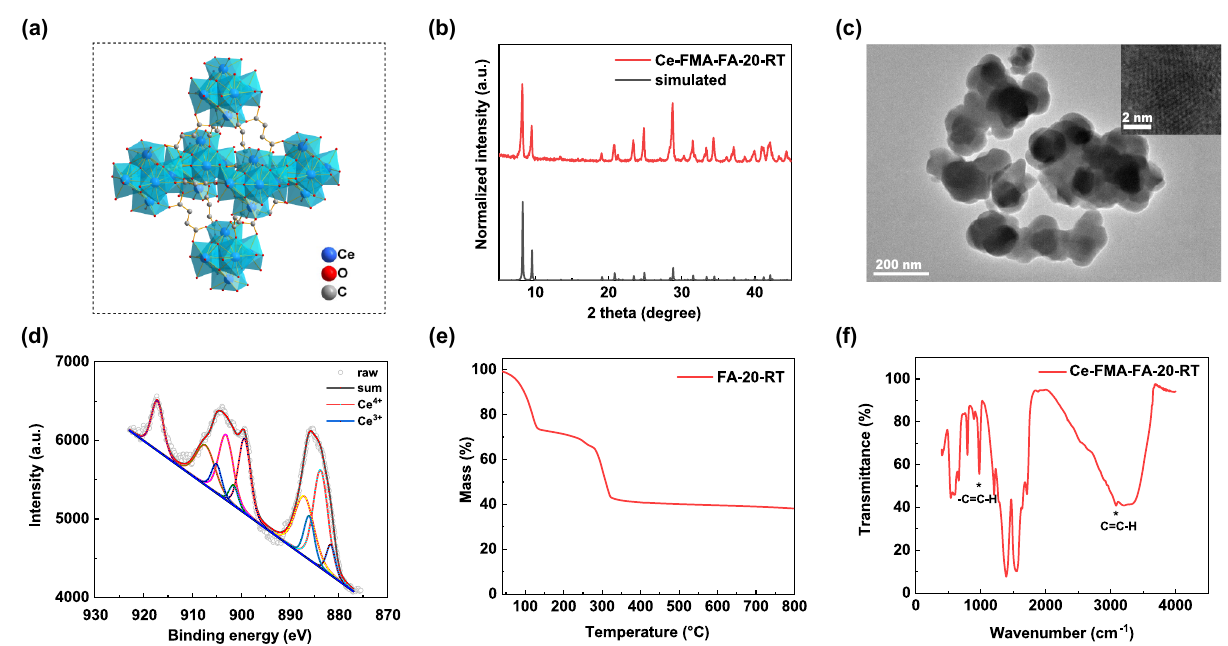
Fig. 2 Characterisation of Ce-FMA modulated by FA with an FA-to-FMA molar ratio of 20. a Structure of Ce-FMA. Ce blue, O red, C grey; hydrogen atoms are omitted for clarity. b XRD pattern of Ce-FMA-FA-20-RT (the black lines at the bottom are simulated patterns from Lammert et al. 31 , with CCDC number 1036903). c TEM images of Ce-FMA-FA-20-RT at different magni fi cations. d XPS spectrum of the Ce 3d signals of the Ce-FMA-FA-20-RT. The red curves correspond to Ce 4 + which are deconvoluted into three Voigt doublets and the blue curves correspond to Ce 3 + which are deconvoluted into two Voigt doublets. The black curve is summed by every deconvoluted peak. e TG curve of Ce-FMA-FA-20-RT analysed under air fl ow. f FTIR spectrum of Ce-